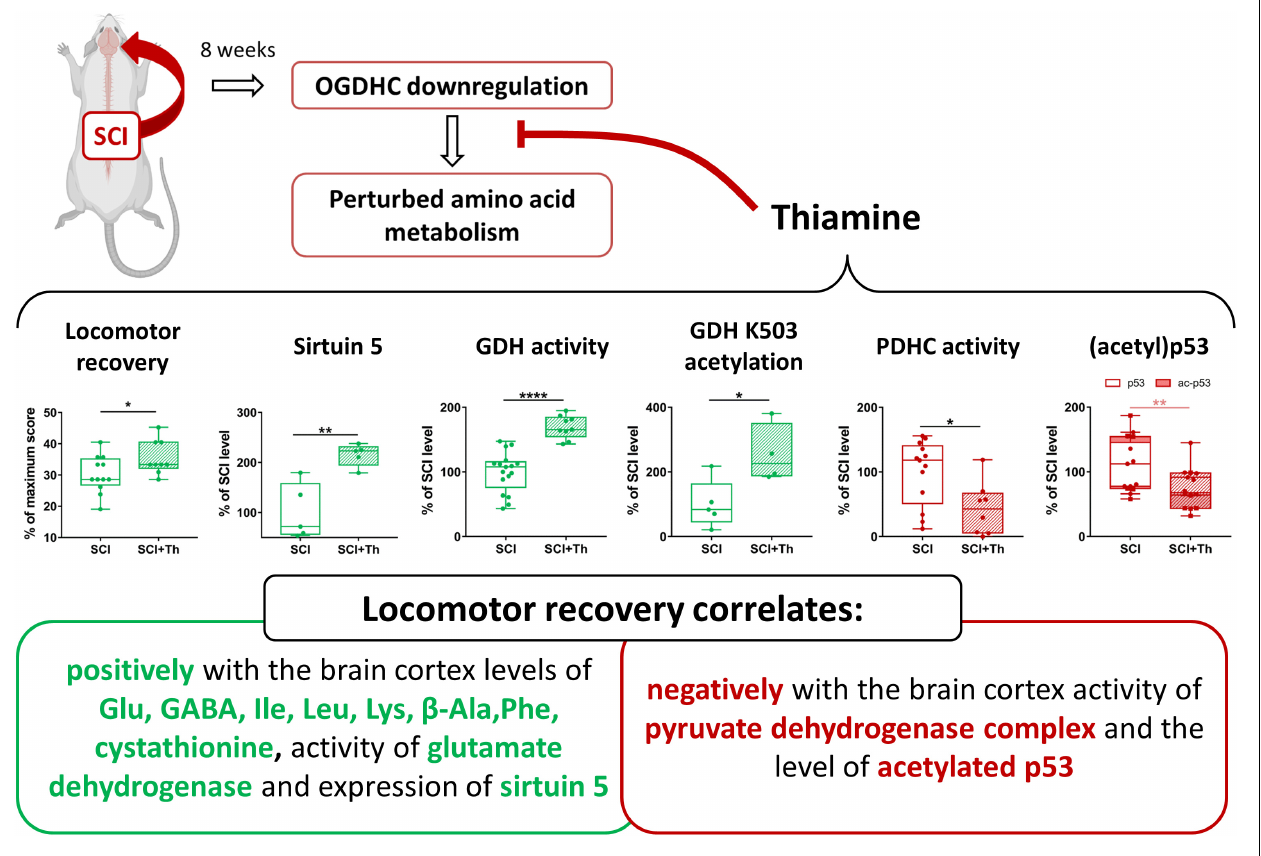
FIGURE 9 | Chronic consequences of SCI and their alleviation by a single post-SCI administration of thiamine. Statistical significance of differences in the brain cortex biochemical parameters of the thiamine-treated and non-treated SCI rats is shown on the graphs, estimated by t -test, after the normal data distribution in each group was confirmed using Shapiro-Wilk test. Different p -values are shown by asterisks as described in Methods under Statistical